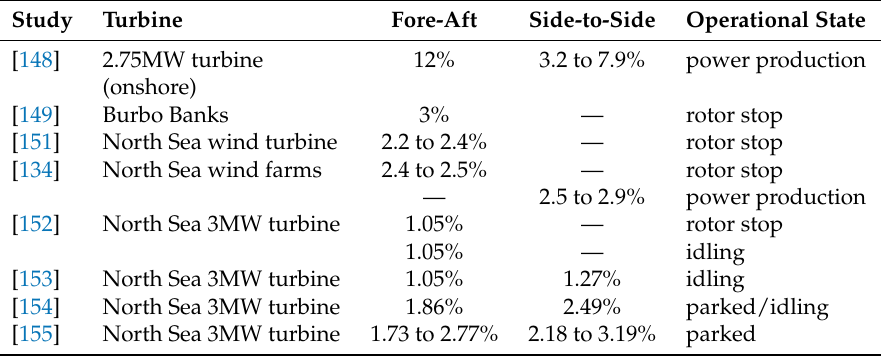
Table 3. Overview of studies presenting validations the first fore-aft and side-to-side damping ratios of wind